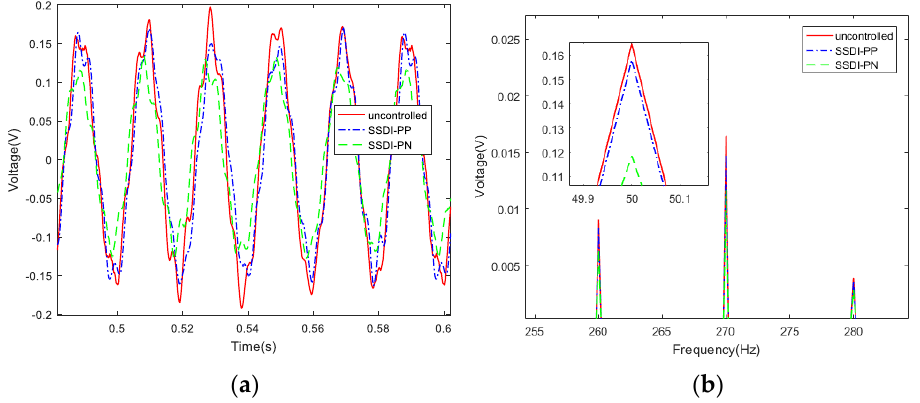
Figure 28. Damping comparison in three cases (white noise): ( a ) displacement response curves in the time domain; ( b ) frequency response curves.